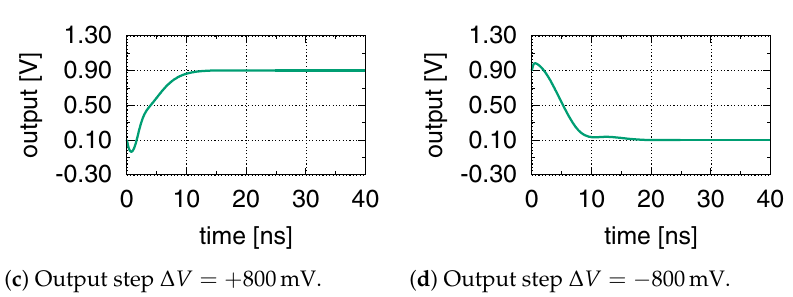
Figure 13. Transient simulation of the closed-loop OTA compensated with the RNMC-ICBFF. The steps are centered around V AGND = 0.5V and are related to the output voltage by ∆ V = v OUT ( n ) − v OUT ( n − 1 )